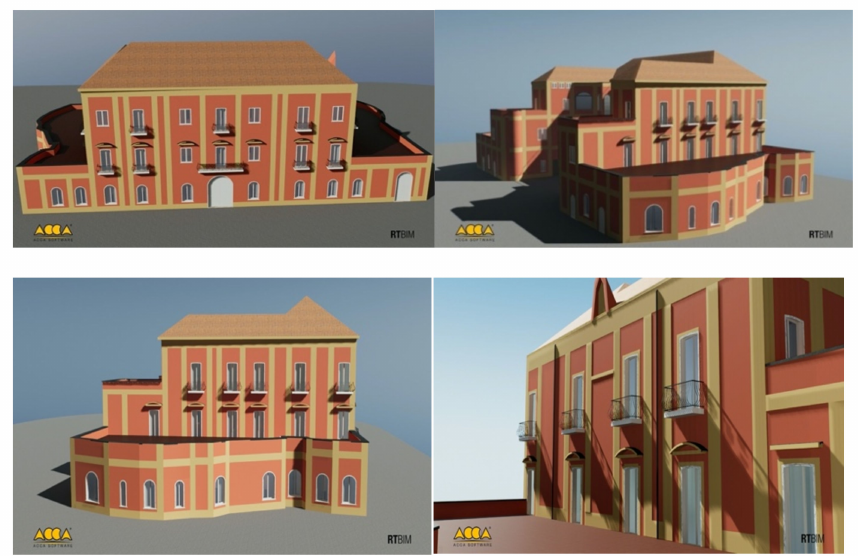
Figure 4. BIM model of Villa Vannucchi.